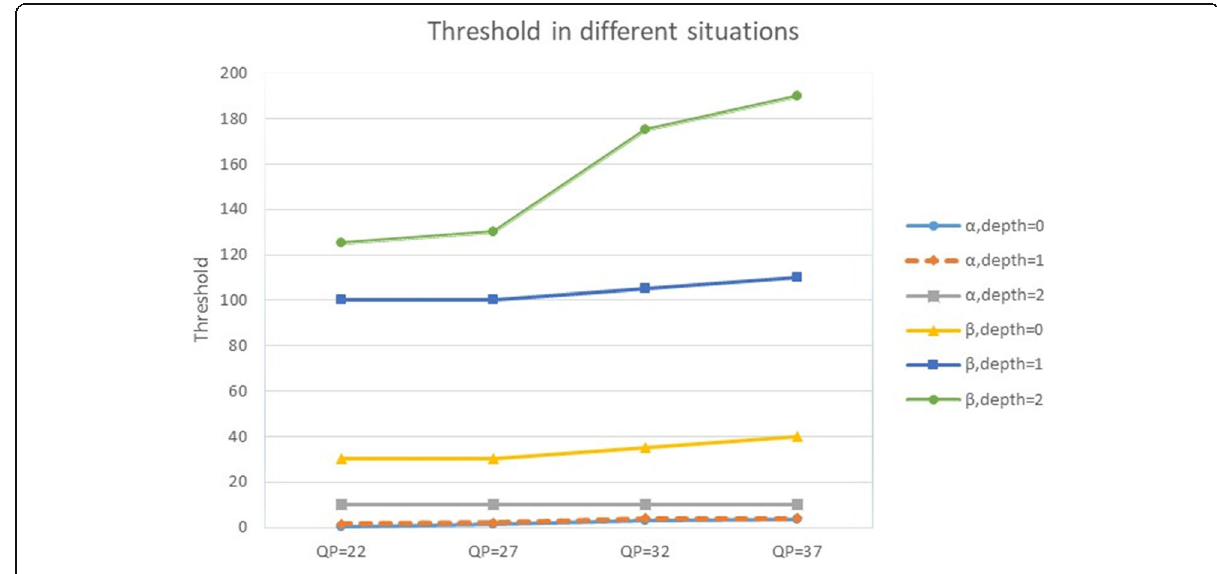
Fig. 10 Threshold range of α and β of HMAD